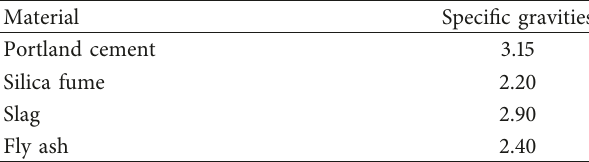
Table 1: Specific gravities for cementitious